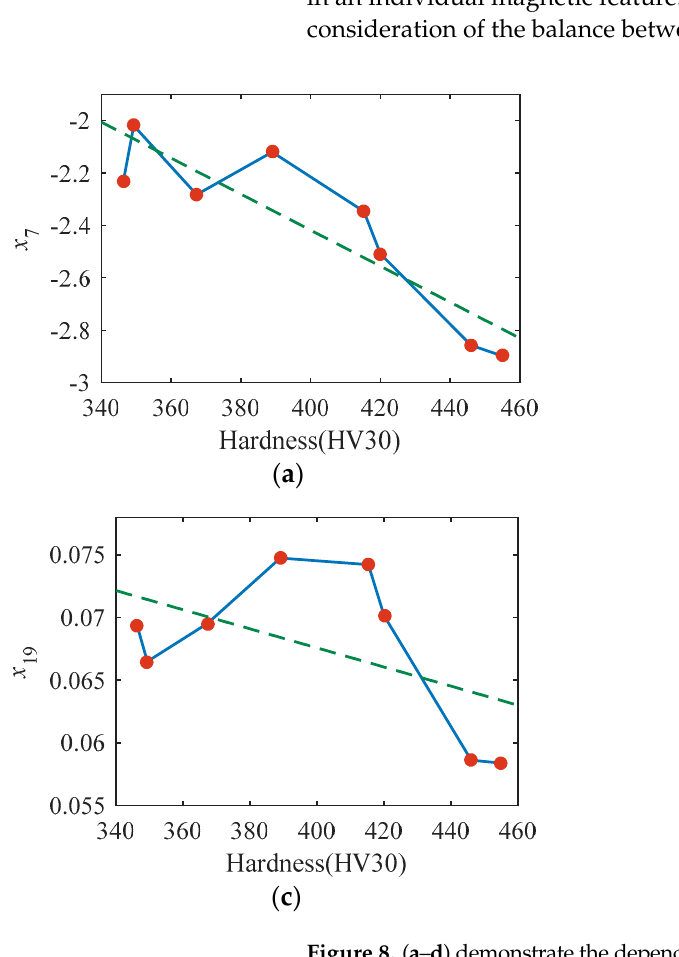
9 of 16 Figure 7. Estimated values of F i and 1/ F i for all the measured magnetic features. Both the performance of magnetic features in surface hardness evaluation and the repeatability of the instrument are key factors to be considered in the feature selection for prediction model training. The curve of 1/ F i (Figure 7) and the curve of β (Figure 6) estimated under dynamic conditions indicated that most of the magnetic features with larger values of β (instability) also had a large value of 1/ F i (poor performance in surface hardness characterization). However, several magnetic features (such as x3 and x6) had a small value of 1/Fi (good ability) but a large value of β (instability) and were not good options as the input nodes of the prediction model. Considering that most of the magnetic features have a value of 1/ F i lower than 0.2, 1/ F